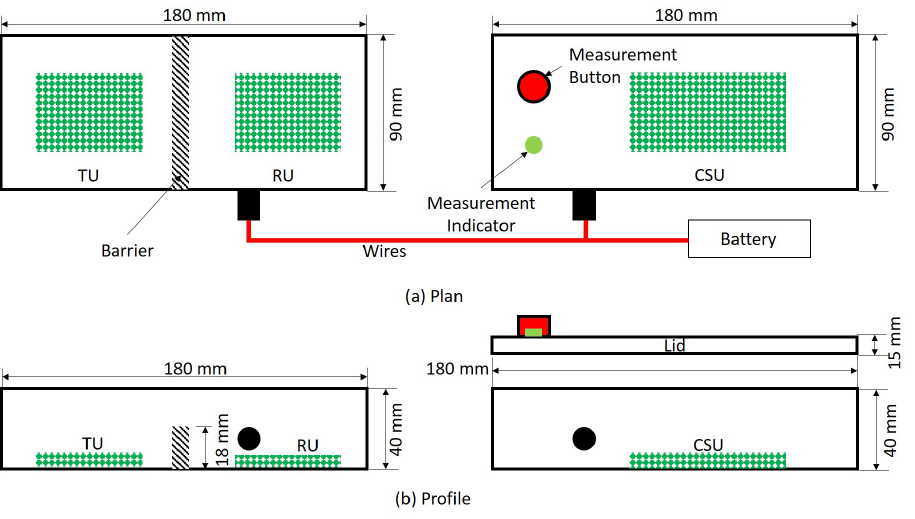
Figure 1. Schematic diagram of the Transmitter Unit (TU), Receiver Unit (RU), and Controller and Storage Unit (CSU) of D-SPARC in ( a ) plan and ( b ) profile